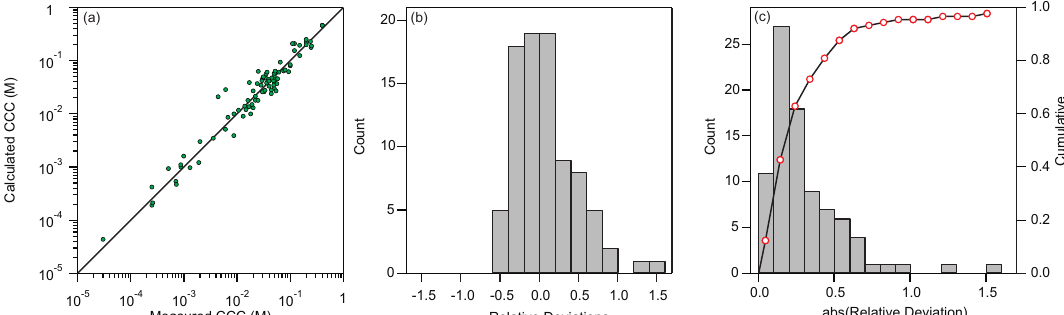
Figure 4. Deviations of calculated and experimental CCCs. ( a ) Comparison of calculated and measured CCCs for all samples. ( b ) Distribution of relative deviations between calculated and measured CCCs. ( c ) Distribution of absolute values of relative deviations between calculated and measured CCCs shown with bars with scale on the left side. The points show the cumulative of the distribution with scale on the right